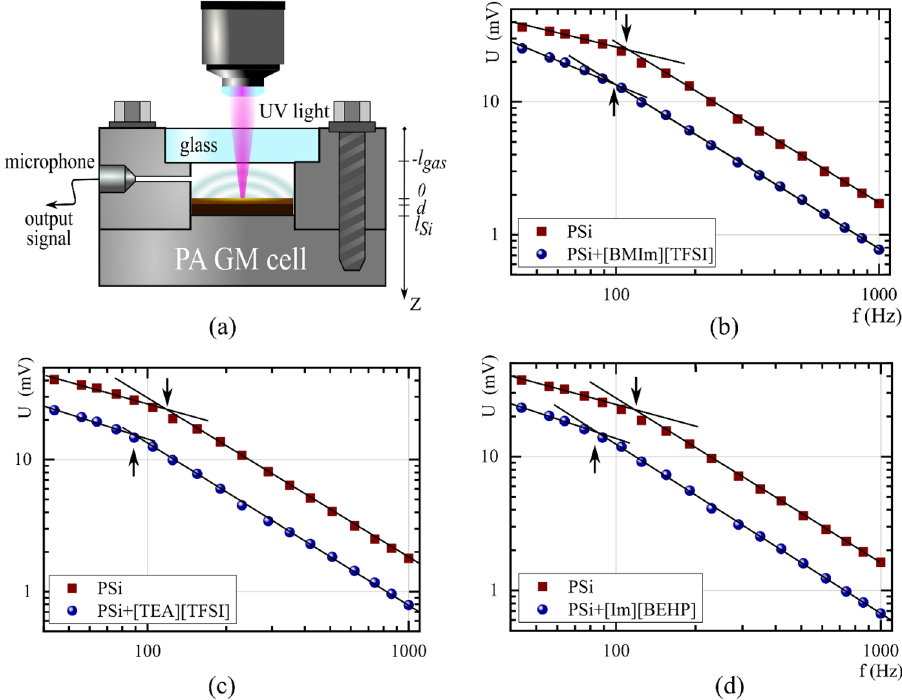
Figure 3. PA cell with gas-microphone registration employed ( a ), amplitude-frequency characteristics of PSi and "PSi/IL" composite systems with IL: [BMIm][TFSI] ( b ), [TEA][TFSI] ( c ), [Im][BEHP] ( d ). Arrows indicate the bending